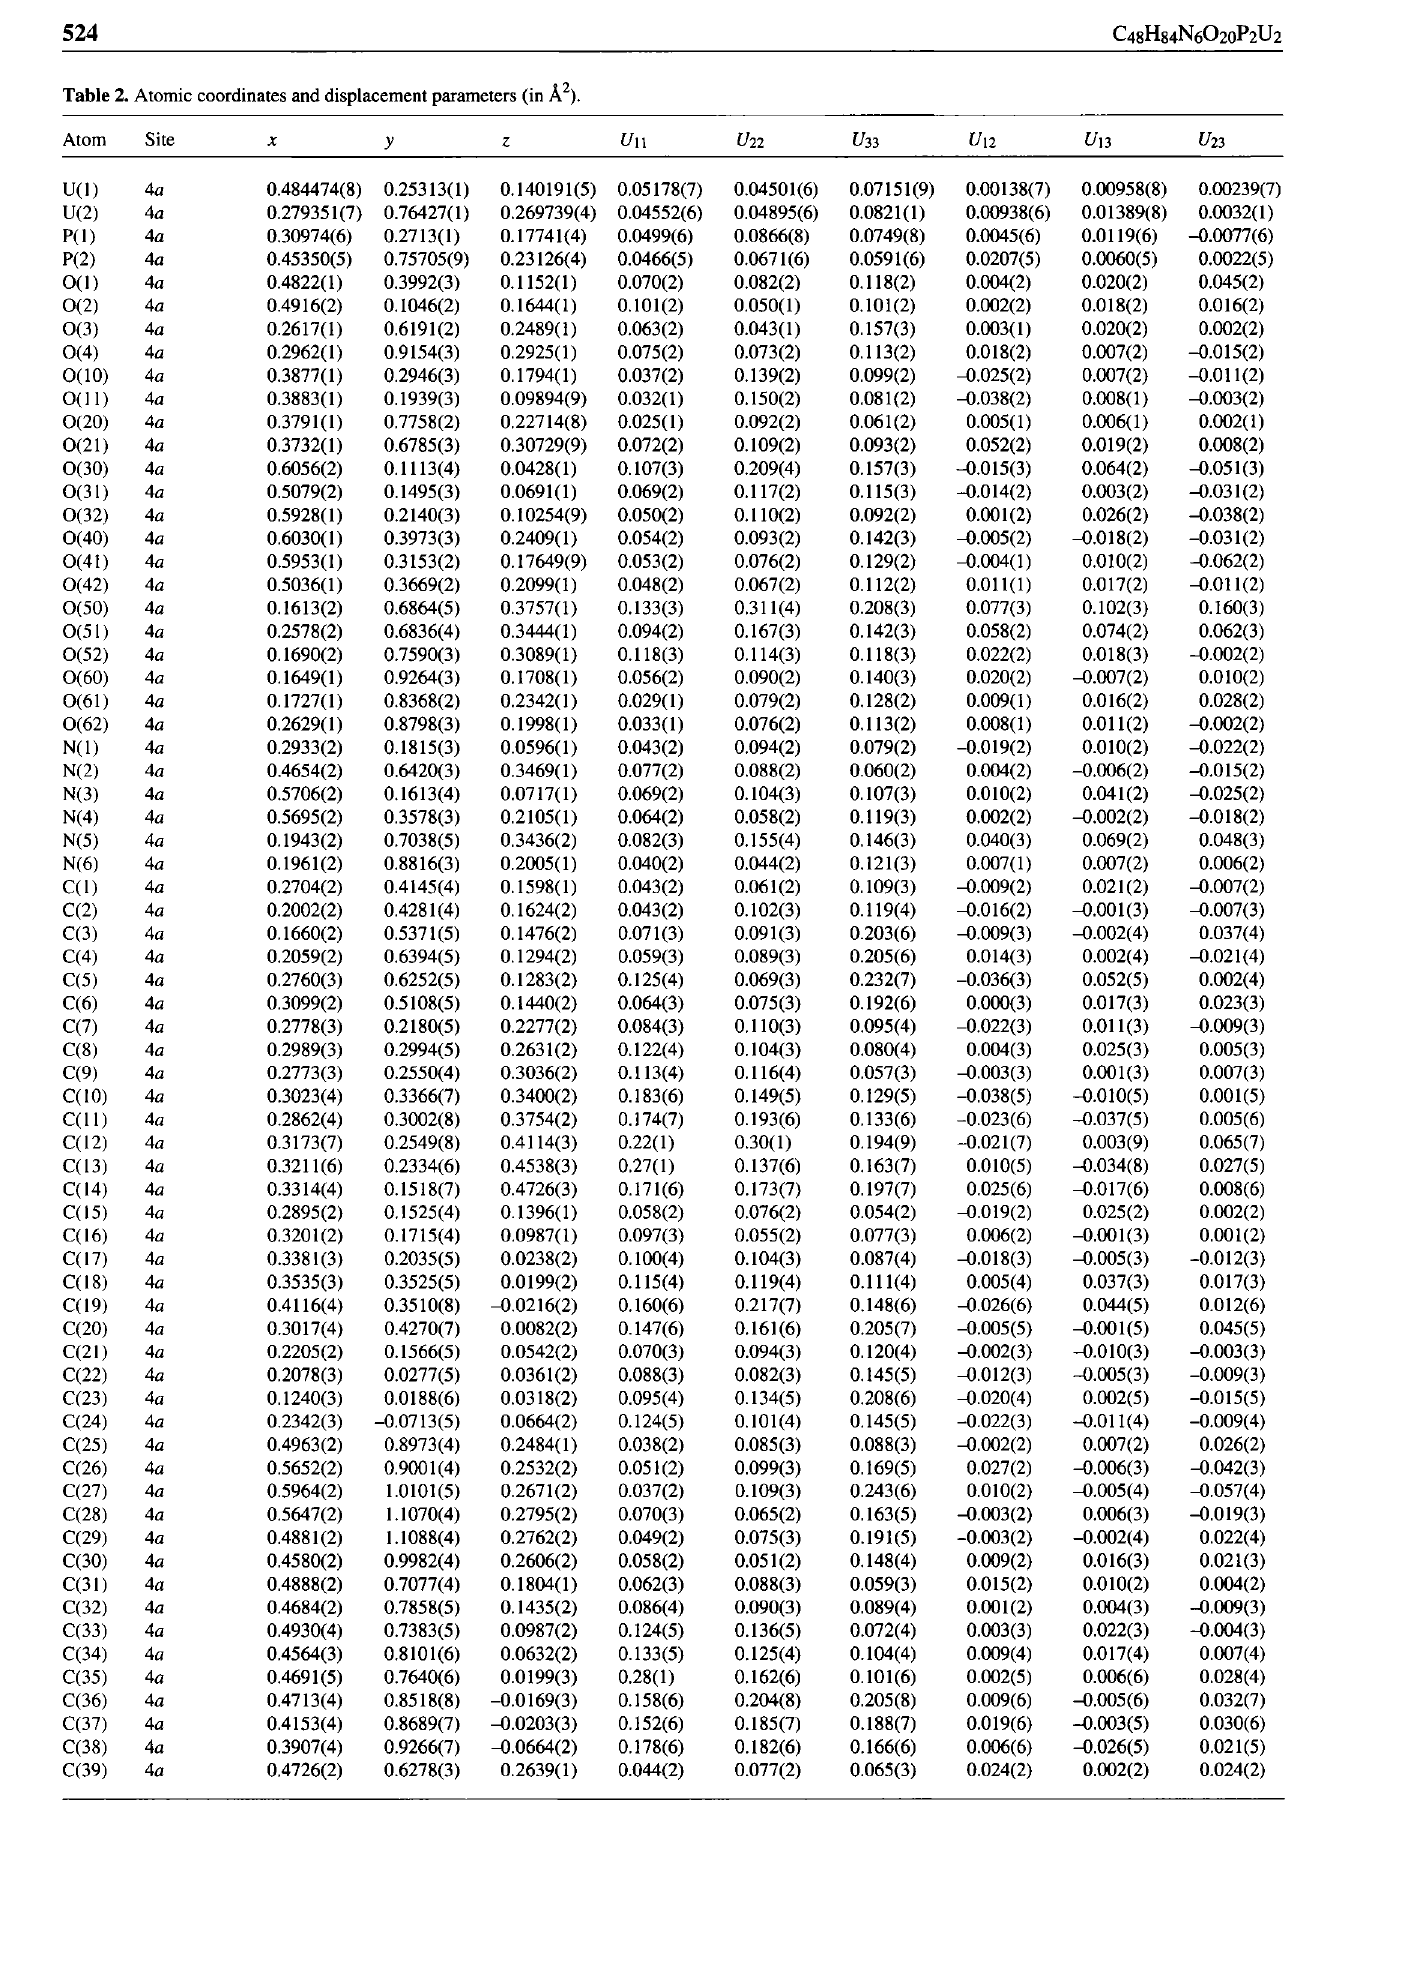
Table 2. Atomic coordinates and displacement parameters (in Ä 2